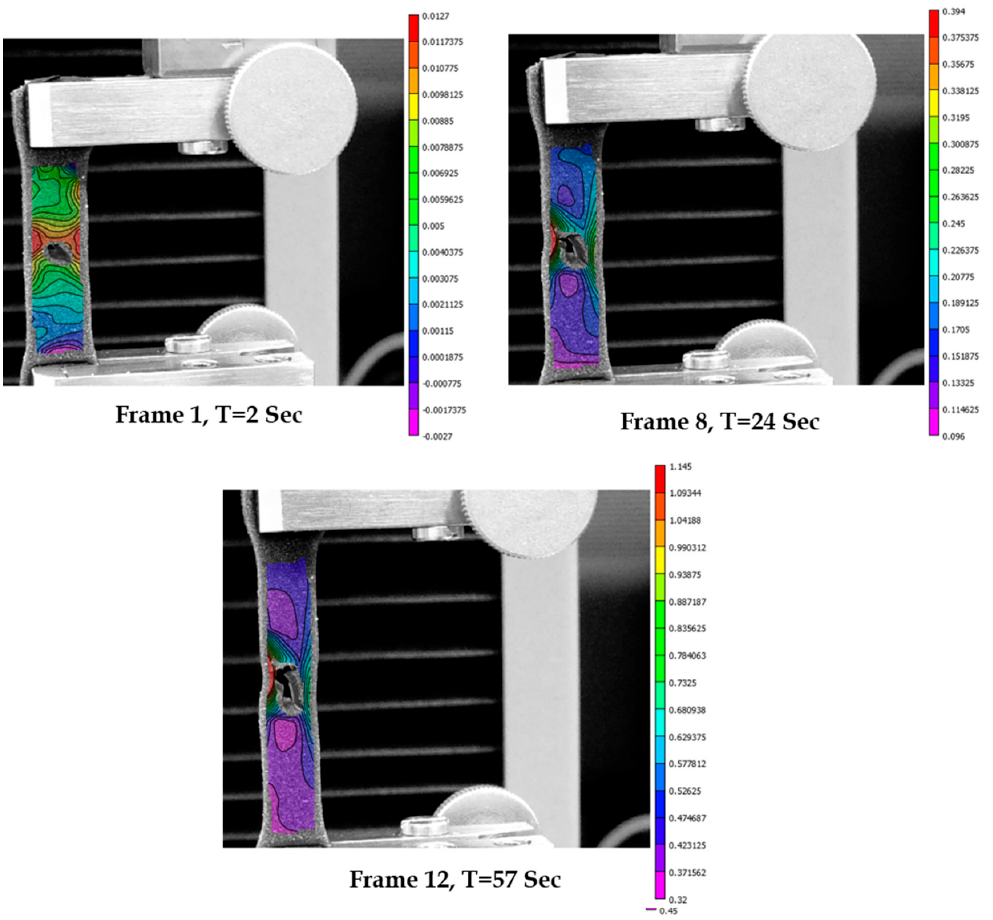
Figure 16. Strain distribution at different times for transverse wound 5 measured using DIC.